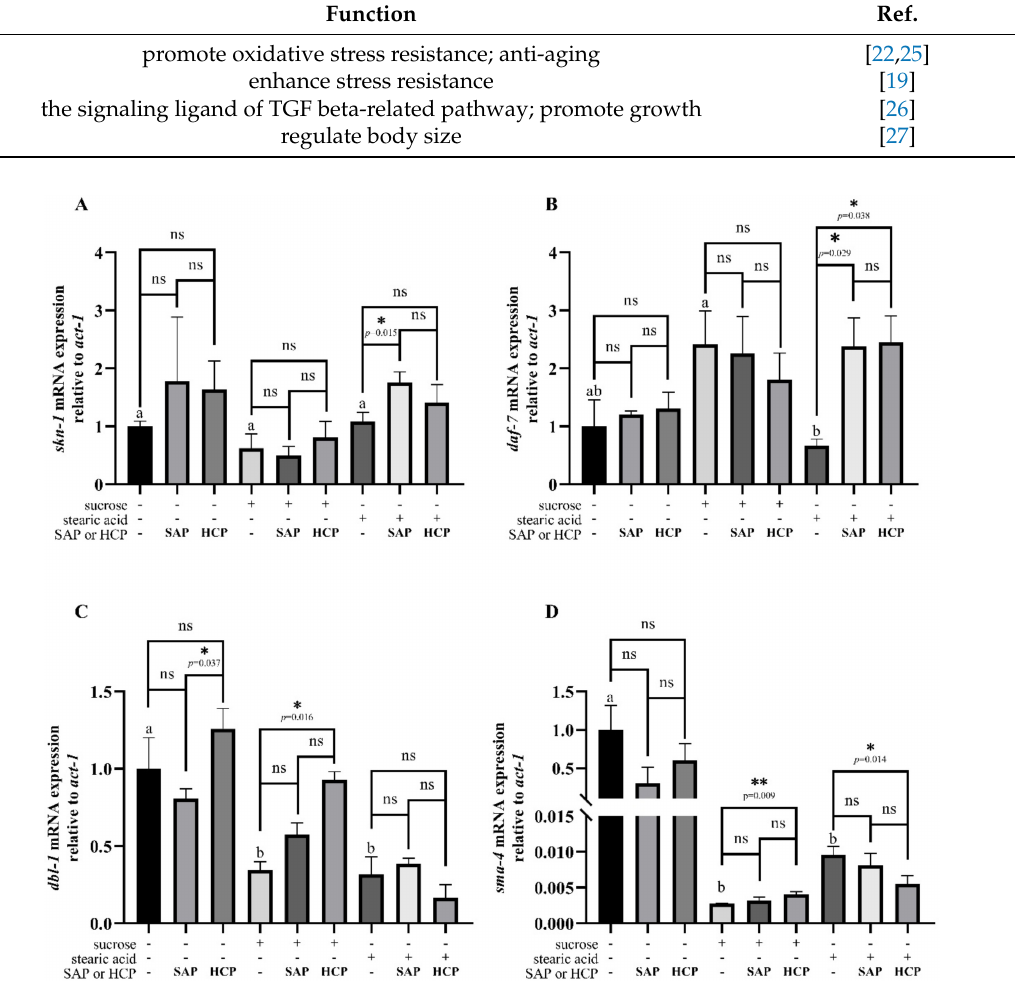
Figure 6. Effects of SAP and HCP on gene expression of C. elegans . Worms were treated with SAP (500 µ g/mL) or HCP (1200 µ g/mL). ( A ) skn-1 mRNA expressions, ( B ) daf-7 mRNA expression, ( C ) dbl-1 mRNA expression, ( D ) sma-4 mRNA expression. Values are expressed as mean ± SEM. Different superscripts were considered significantly different, ANOVA followed by Tukey’s multiple- comparison test. * p <0.05; ** p < 0.01; Student’s t -test